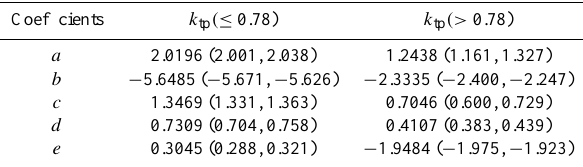
Figure 2. Relative humidity and albedo effects on the k tp − k dp re- lationship. Table 2. Logistic model coefficients for clearness index classes. The values given in brackets are the 95% confidence interval.